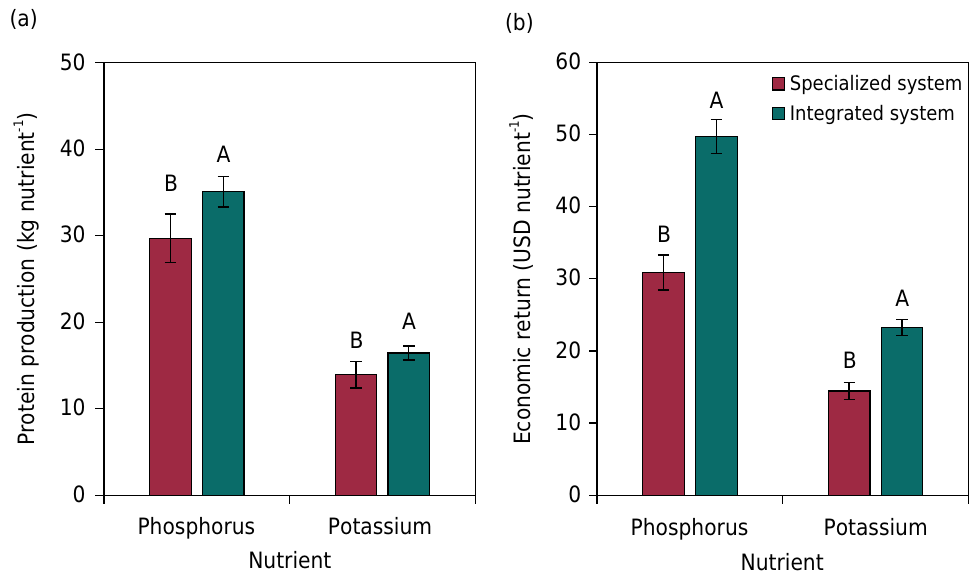
Figure 6. Phosphorus and potassium use efficiency for protein production (a) and economic return (b) as affected by grazing. Different letters denote significant differences as per Tukey’s test